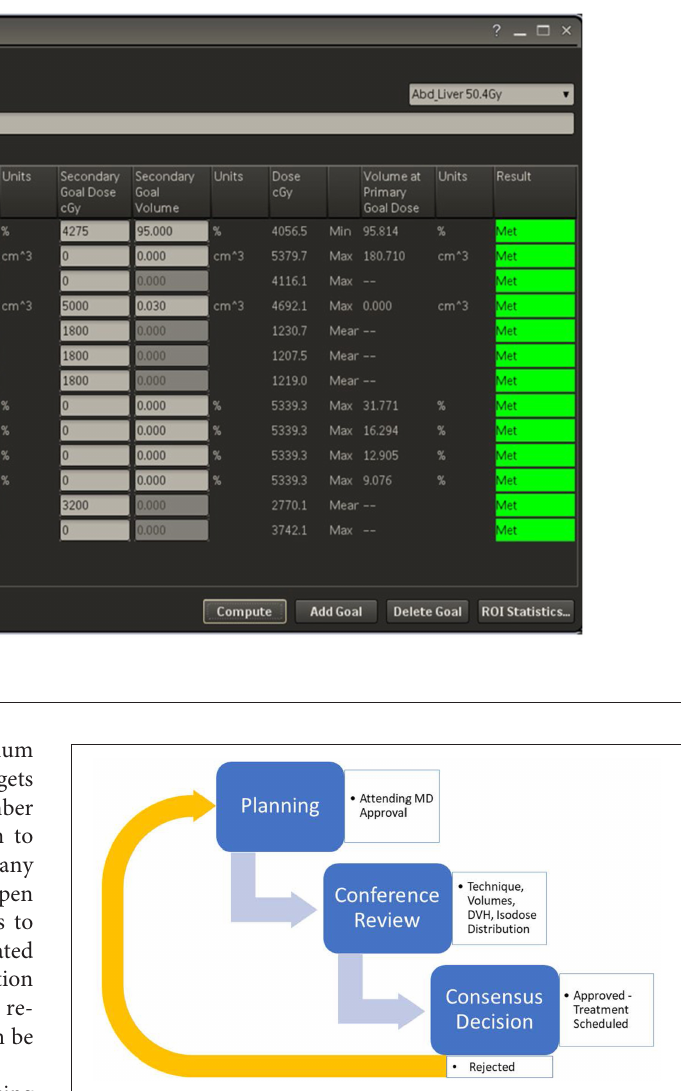
FIGURE 2 | General description of the Group Consensus Pre-Treatment Peer review model in